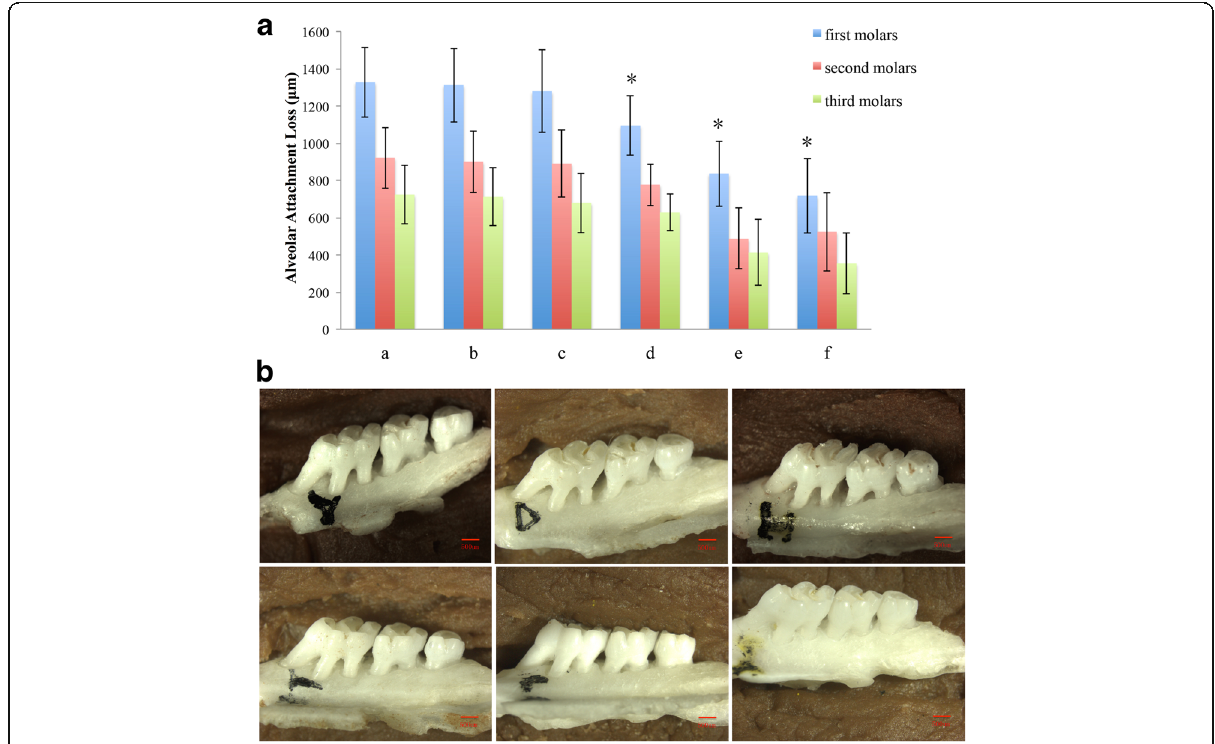
Fig. 1 Detection of rat alveolar bone damage by stereomicroscopy and immunohistochemical staining. ( a) and ( b ) Alveolar bone loss in each group was measured along the long axis of the teeth using a stereomicroscope. a : P. gingivalis W83 alone; b : P. gingivalis W83 plus 6.25 μ g/mL of Nal-P-113; c : P. gingivalis W83 plus 25 μ g/mL of Nal-P-113; d : P. gingivalis W83 plus 100 μ g/mL of Nal-P-113; e : P. gingivalis W83 plus 400 μ g/mL of Nal-P-113; f : control group, without P. gingivalis or Nal-P-113. The data are presented as the means of 12 rats in each group ( a ). The images were selected from each group at random ( b